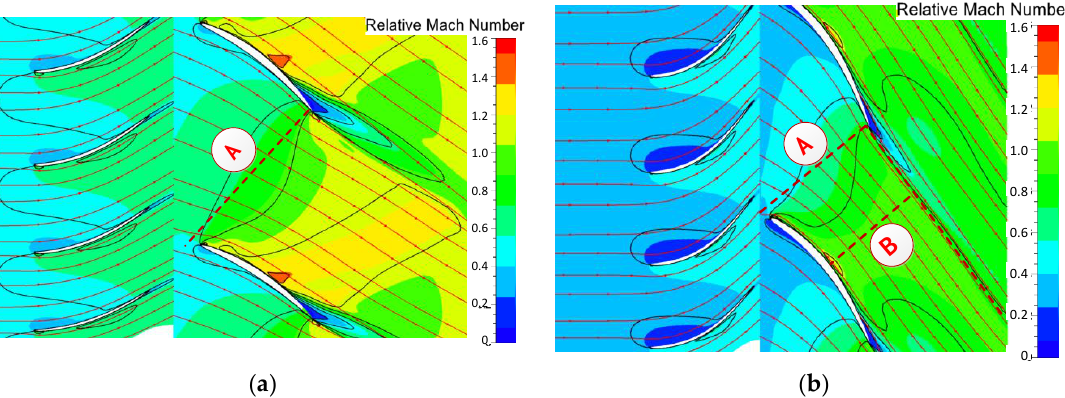
Figure 6. Mach Number Contour of the tip turbine (50% span). ( a ) Conventional design; ( b ) High reaction design.